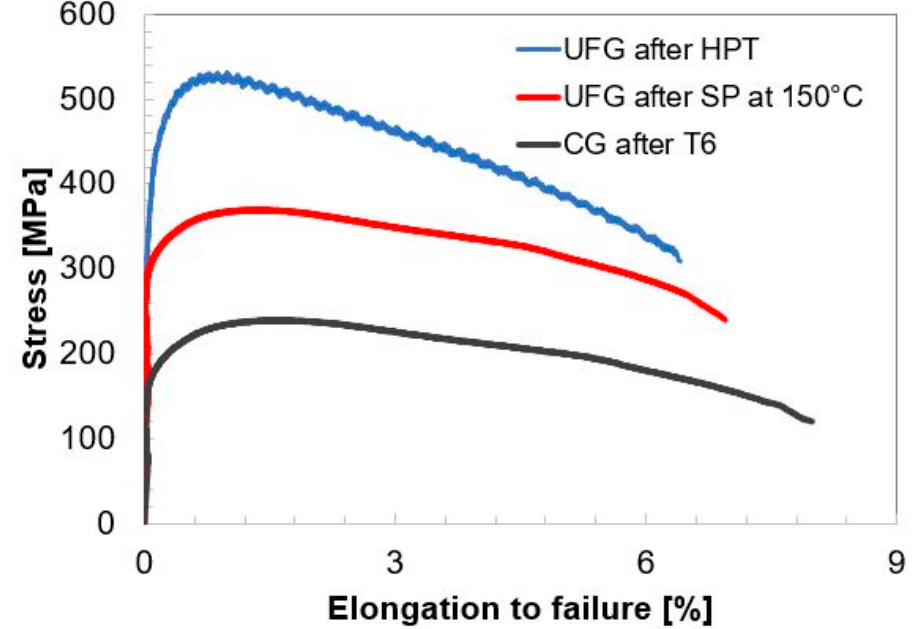
Figure 9. The room temperature tensile curves for the T6-treated coarse-grained and for the UFG 6060 alloy in the states after HPT and after SP at 150 ◦